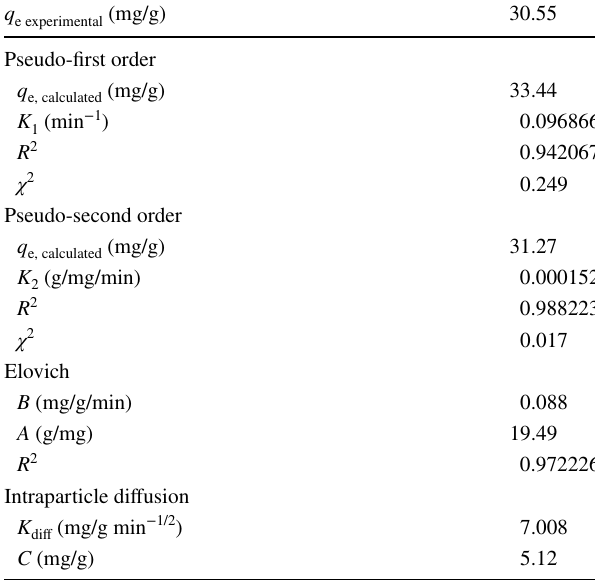
Table 3 Adsorption kinetics of Rh-B on AgNPs